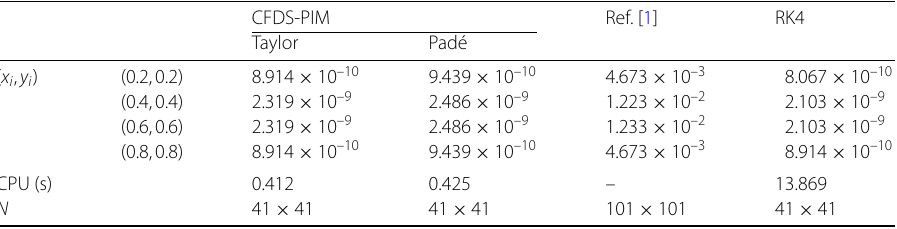
Table 6 The error comparison between CFDS-PIM and other method with spatial step sizes h x = h y = 2.5 × 10 –2 and time step size τ = 2 × 10 –5 at t = 2 for case 1 of Example 4 CFDS-PIM Ref. [1] RK4 Taylor Padé ( x i , y i